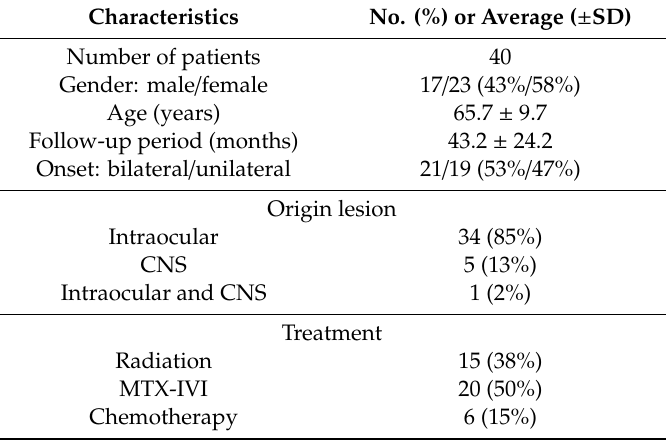
Table 1. Patient demographics, lesion laterality at onset, origin lesion and treatment.